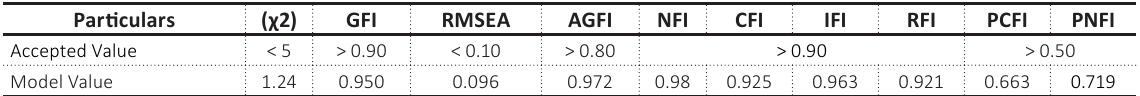
Table 11. Goodnes s of fit